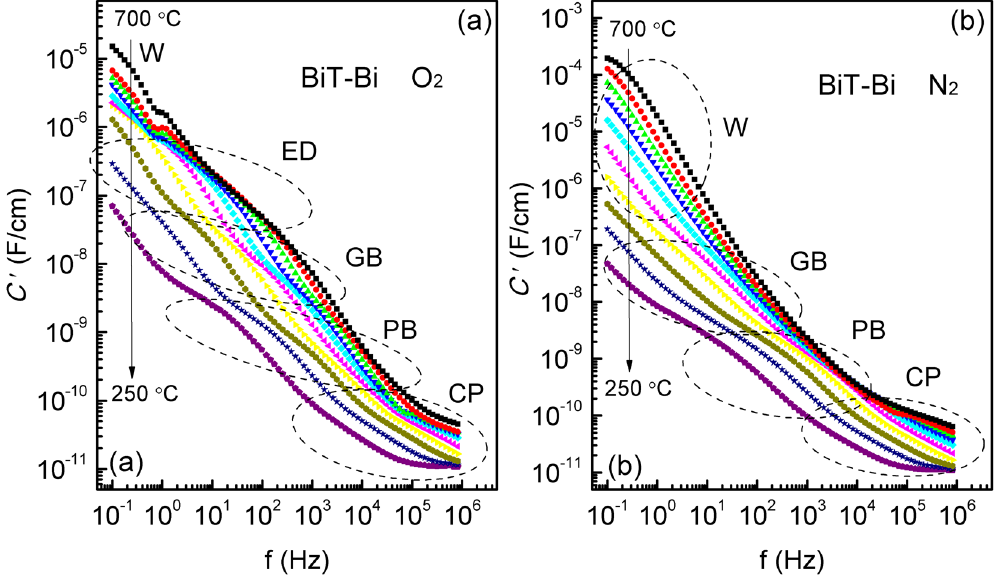
Figure 5. 250–700 °C C ′ spectroscopic plots of the ( a ) O 2 - and ( b ) N 2 -processed BiT-Bi